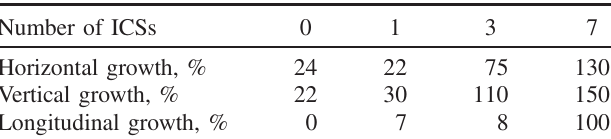
TABLE IV. Rms-emittance growths for the lattice with several